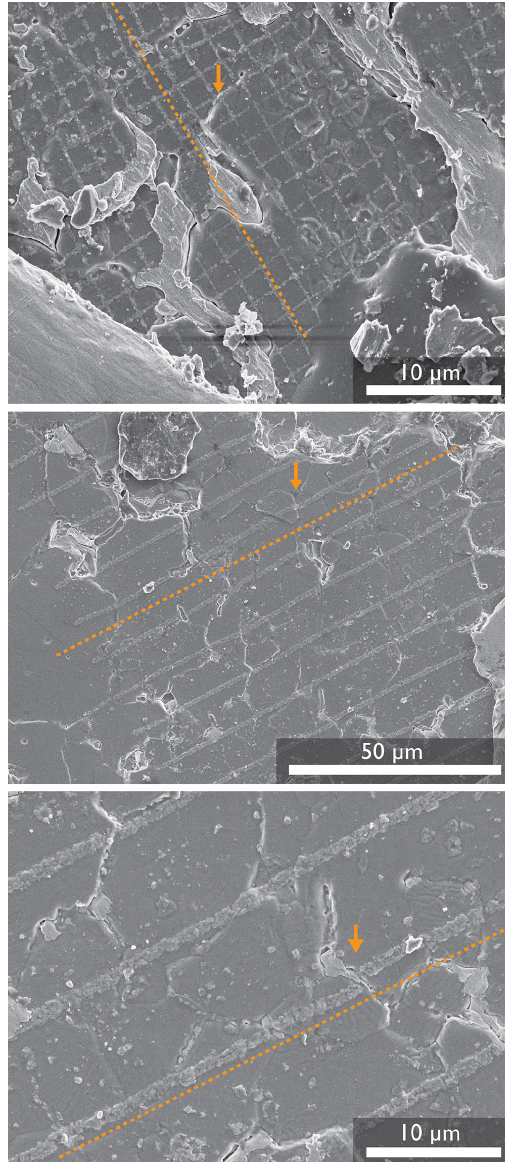
Figure 12. Secondary electron images of a gridded fine-grained San Carlos olivine after deformation at T = 1100 ◦ C and P c = 300MPa to 5% shortening at 1 × 10 − 5 s − 1 . The deformed lines show clear offsets at grain boundaries. The dotted orange lines show evidence of the deformation of the lines in the grid. The orange arrows show grain boundary displacement.